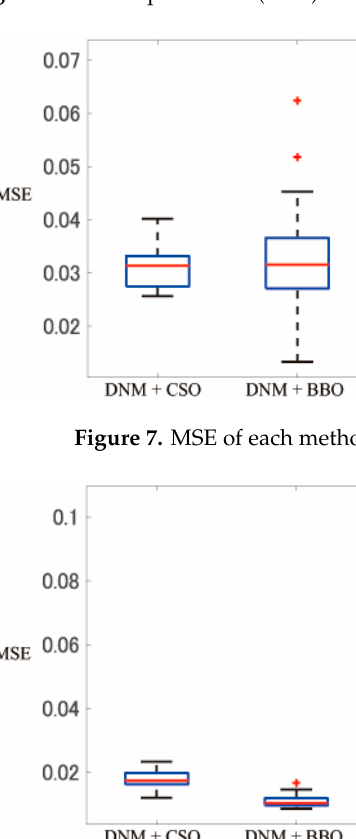
Figure 6. Mean square error (MSE) of each method in F1.